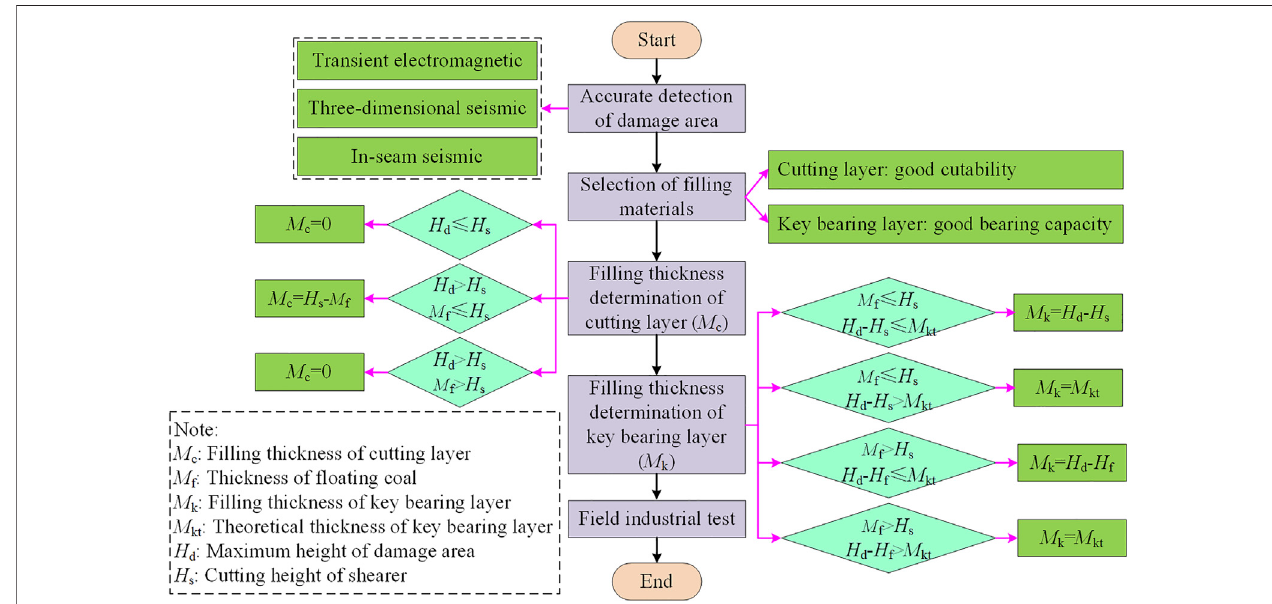
FIGURE 4 | Critical procedures for the FBRM method.